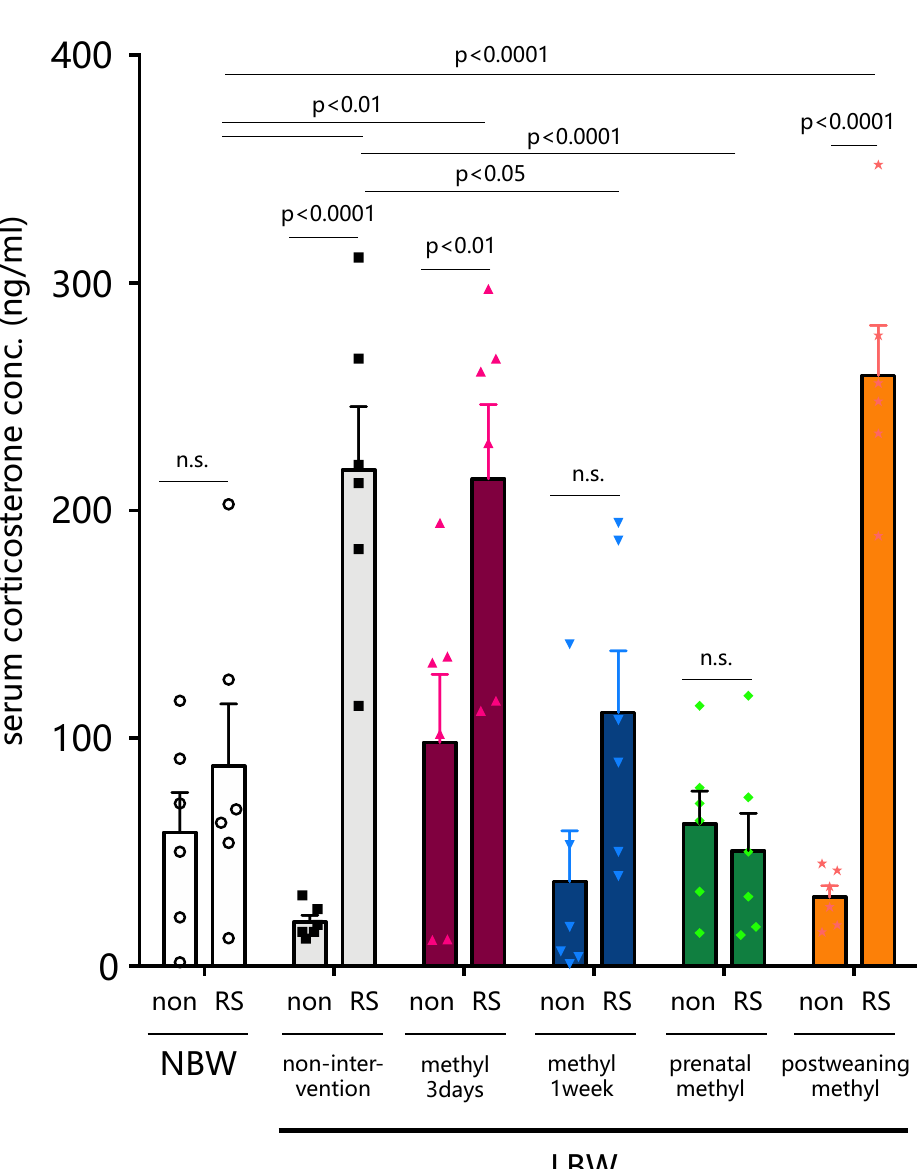
Figure 5. Blood corticosterone levels in restraint stress-exposed (RS) rats with methyl modulator nutritional intervention. Blood corticosterone levels of restraint stress-exposed control rats (NBW) and of LBW rats were measured ( n = 6). Statistical analysis was performed using 2-way ANOVA followed by Tukey’s post hoc test for multiple comparisons. Offspring from the 3-day intervention